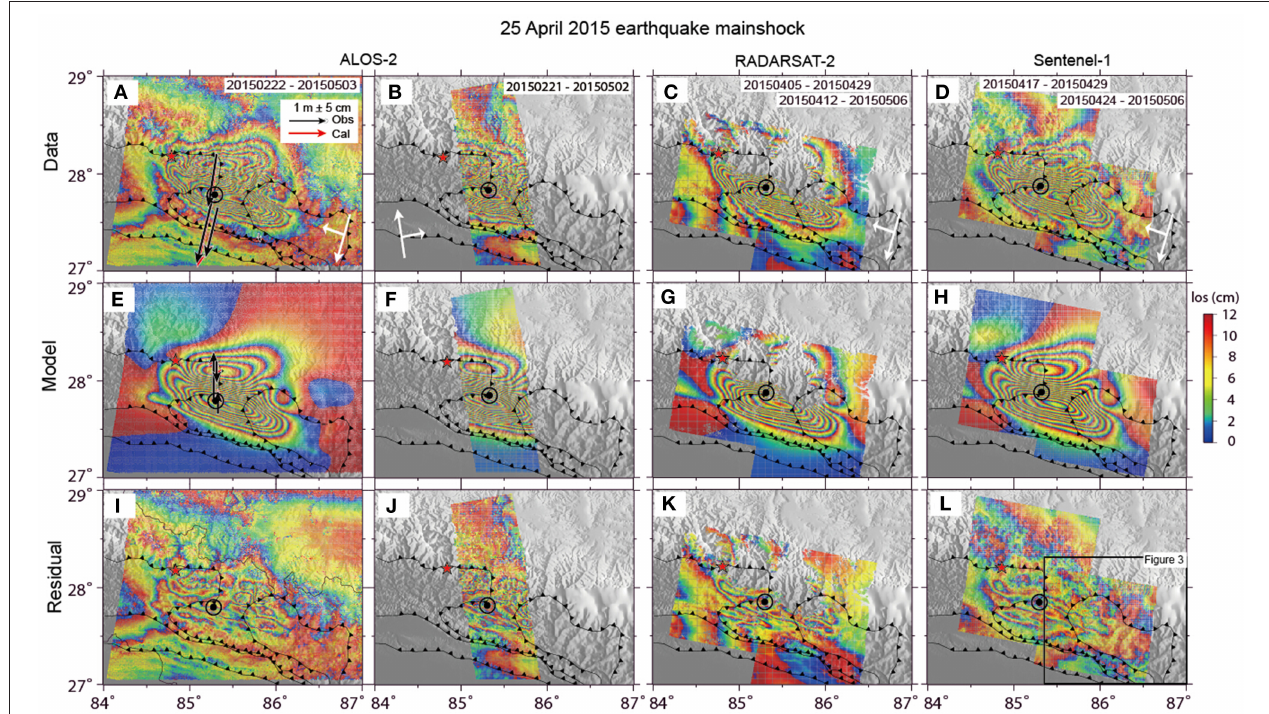
FIGURE 2 | Earthquake mainshock, as seen from radar satellites that allow quantifying displacements in the Line of Sight (LOS) as indicated by white arrow in (A–D). Upper row is the data ( A, B, wideswath ALOS-2; C, RADARSAT-2 from two tracks, and D, Sentinel-1 from two tracks). Center row (E–H) is the model solution. Bottom row (I–L) shows the residual after subtracting the model from the data. Red star depict the location of the mainshock epicenter, located to the west of the deformation area. Fault lines are the MFT, MBT, and MCT from south to north, after (Webb et al., 2011). Kathmandu shown by black circle. The black insert box shown on (I) is shown the area of the largest aftershock shown in Figure 3 . This figure is drawn using GMT software.